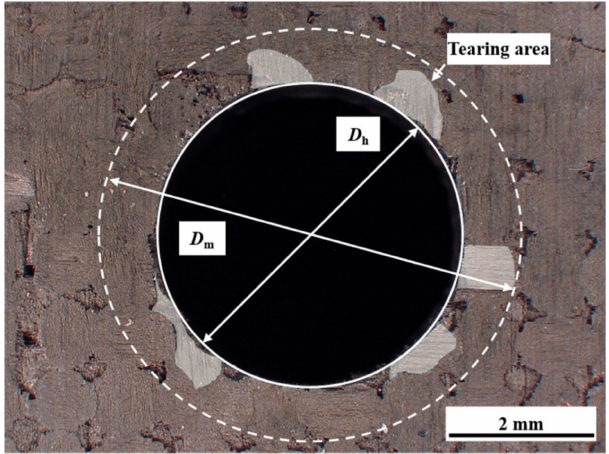
Figure 13. Schematic of the tearing